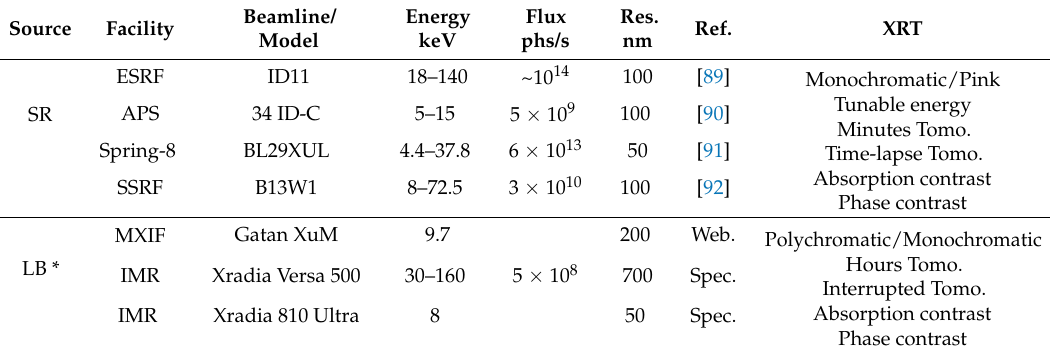
Table 1. Typical SR beamlines and LB facilities for X-ray nano tomography with full field